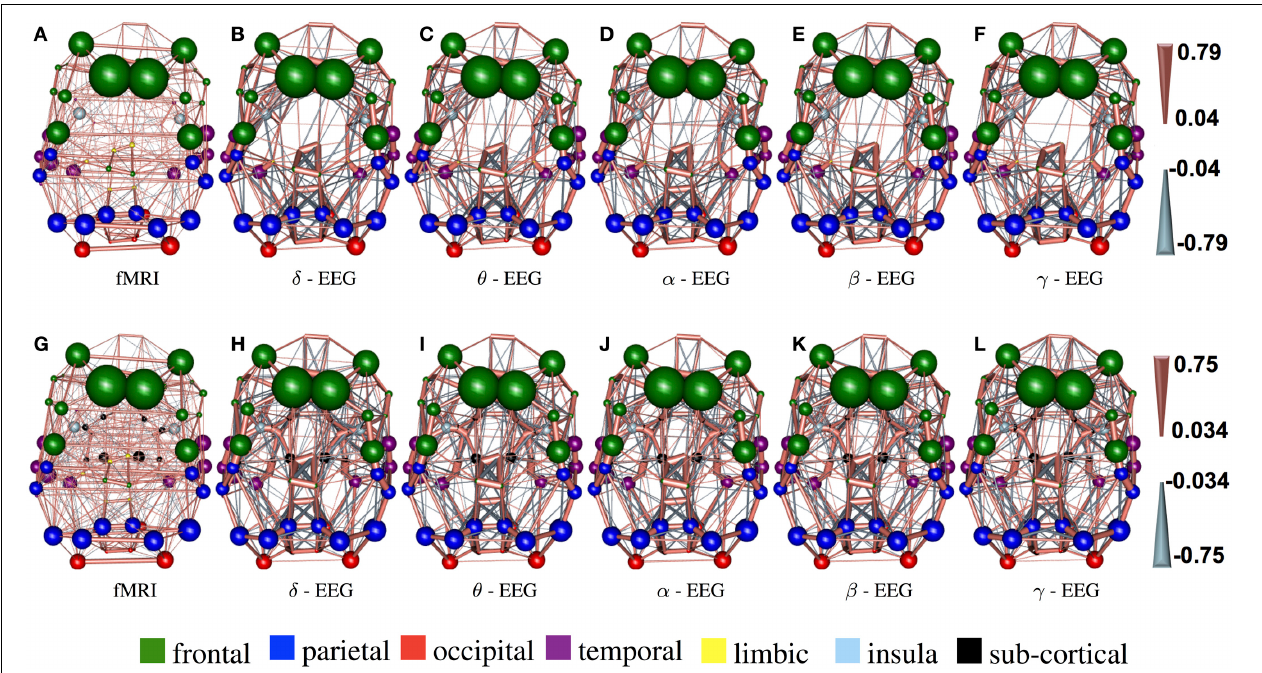
FIGURE 3 | The connections with the 15% highest absolute value in Figure 2 (WTS) are shown as 3D graphs in standard space. Connections are represented as cylinders with salmon color when they are positive and slate-gray when they are negative. Brain regions are represented with spheres. Their centers and radii represent the